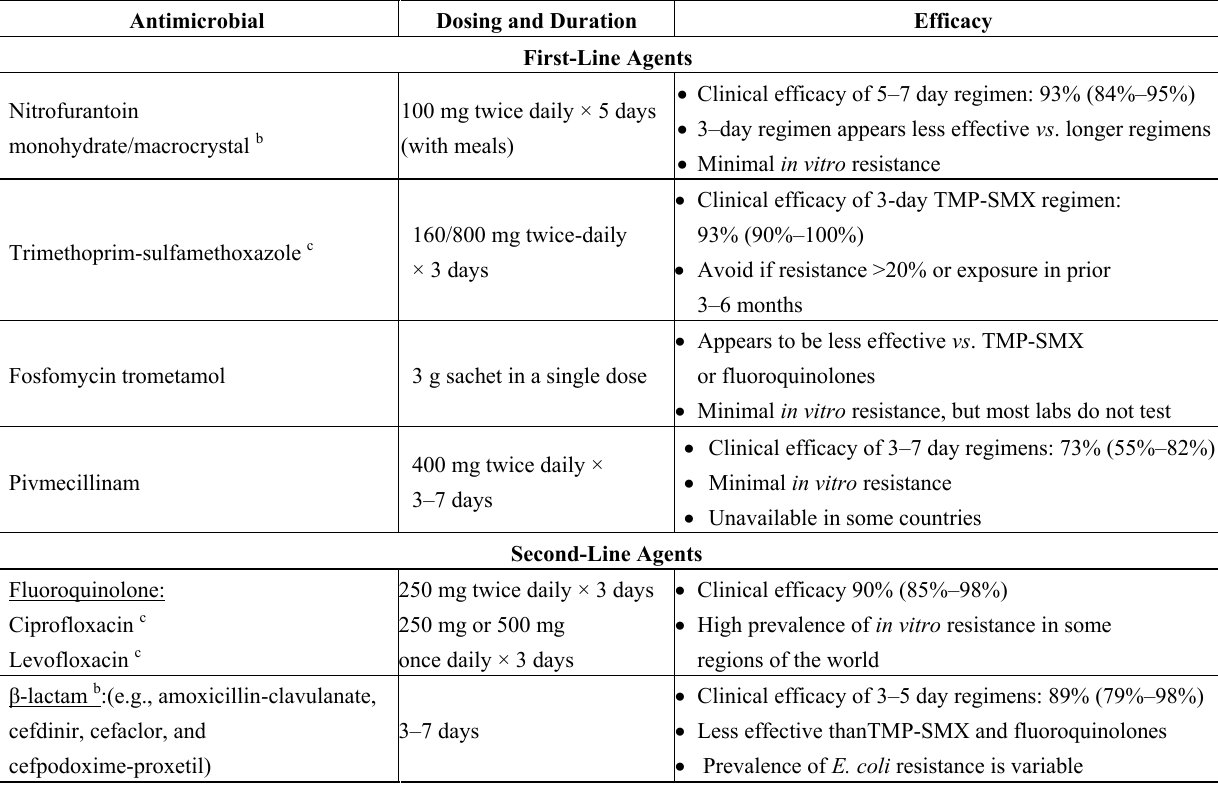
Table 2. Antimicrobial management of acute uncomplicated cystitis a